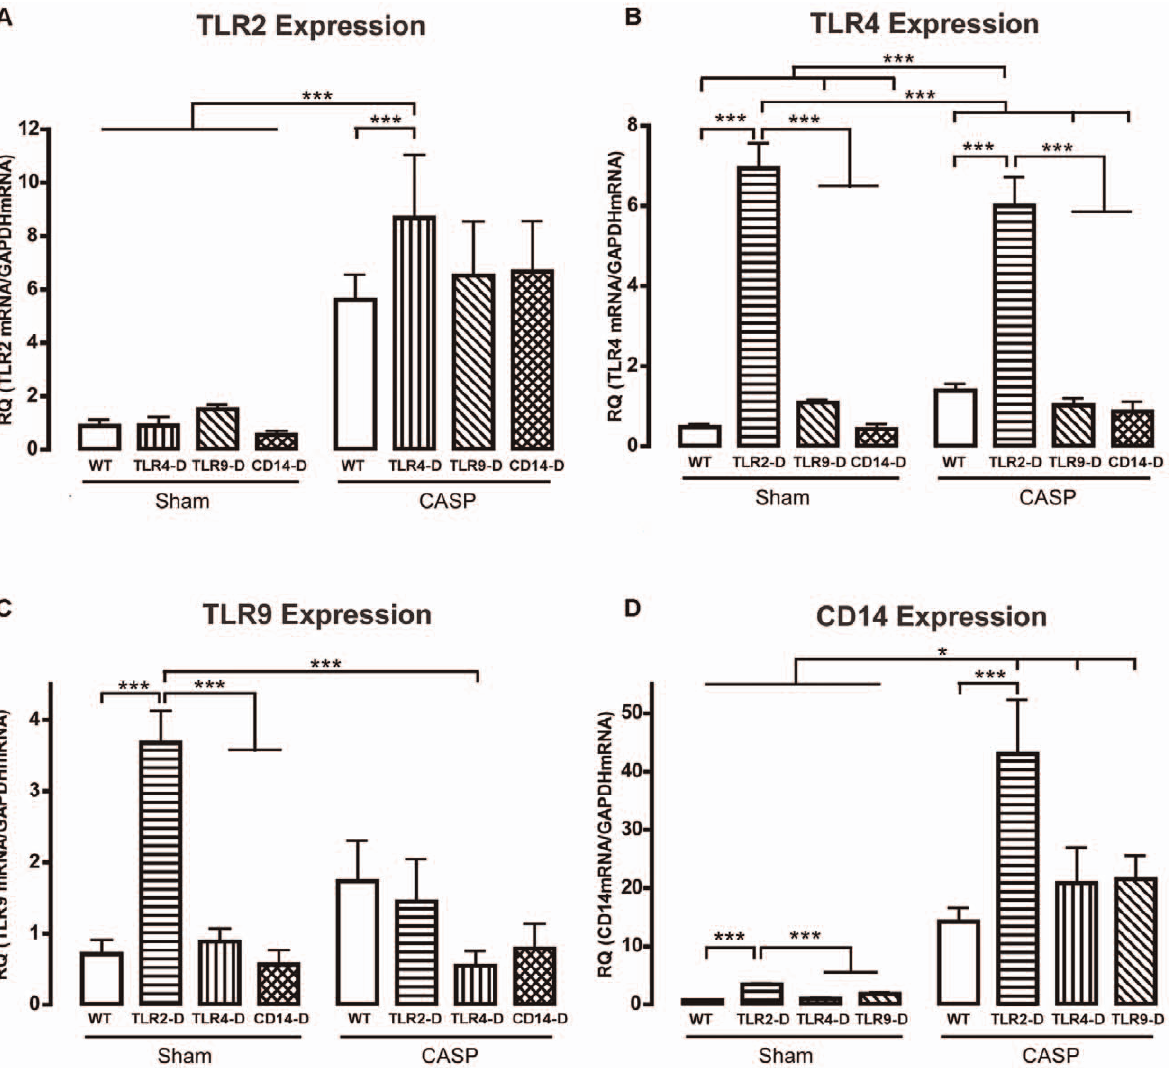
Figure 1. Effects of CASP and expression of PRR expression in the murine vessel wall. PRR mRNA expression during control conditions and following CASP-surgery (TLR2 (A), TLR4 (B), TLR9 (C), CD14 (D)). TLR2-D mice showed significantly higher baseline levels of TLR4 (B), TLR9 (C) and CD14 (D) compared to the other groups. All PRRs appeared to be regulated after CASP; however, only TLR2 and CD14 mRNA expression reached the level of significance (A, D; *p , 0.05; **p , 0.01; ***p , 0.001; n $ 5 animals in each group; mean 6